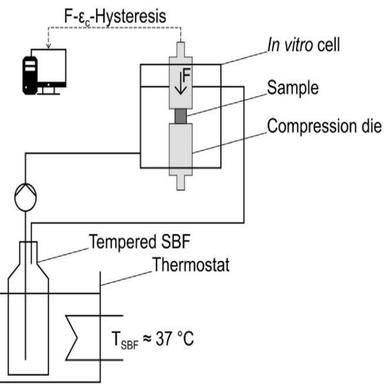
Schematic experimental setup for in vitro fatigue tests with tempered simulated body fluid (SBF).